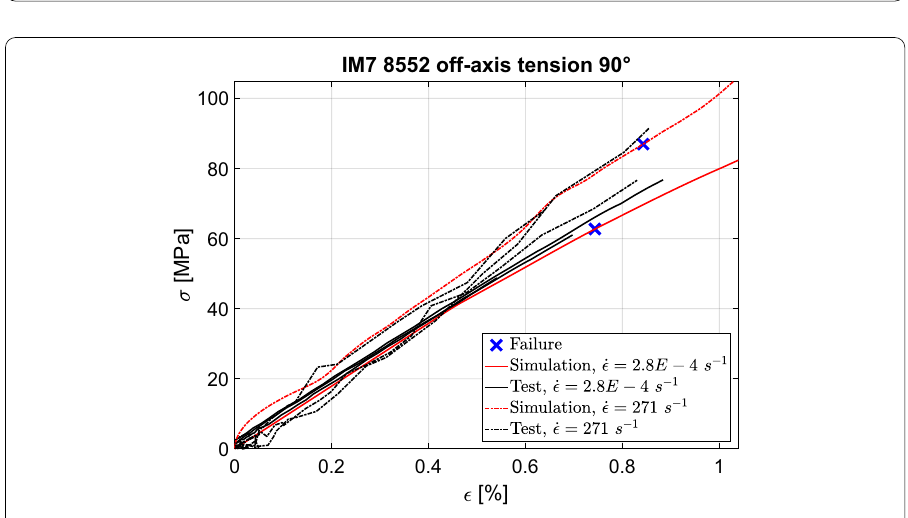
Fig. 15 True stress–true strain curves for the tensile tests and simulations, 90